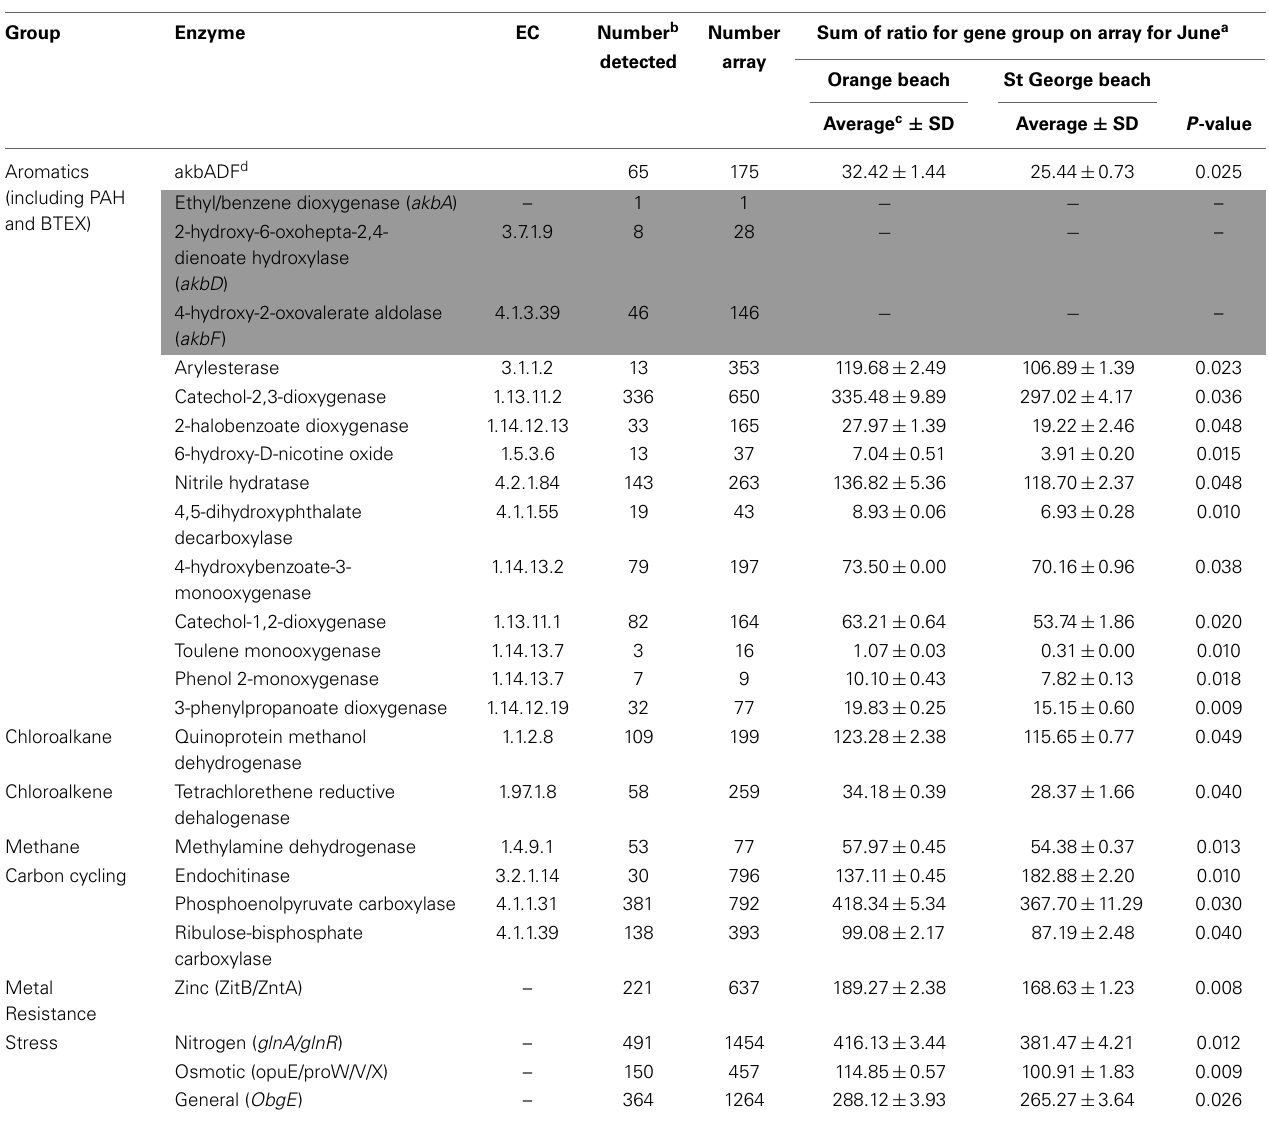
Table 2 | Individual genes showing a significant increase ( p < 0 . 05) at oil-impacted Orange beach compared to non-impacted St. George beach during the month of June.